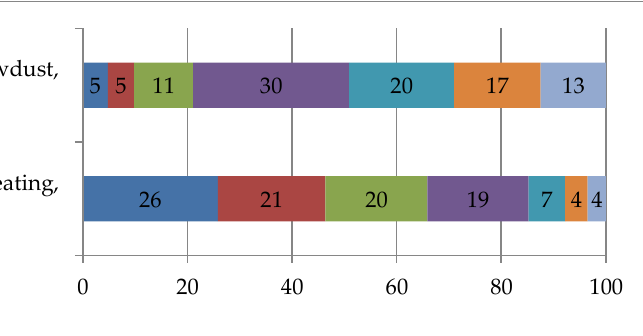
Figure 2. Frequency distribution of the statement ″ There is outdoor access for the fattening pigs ″ .